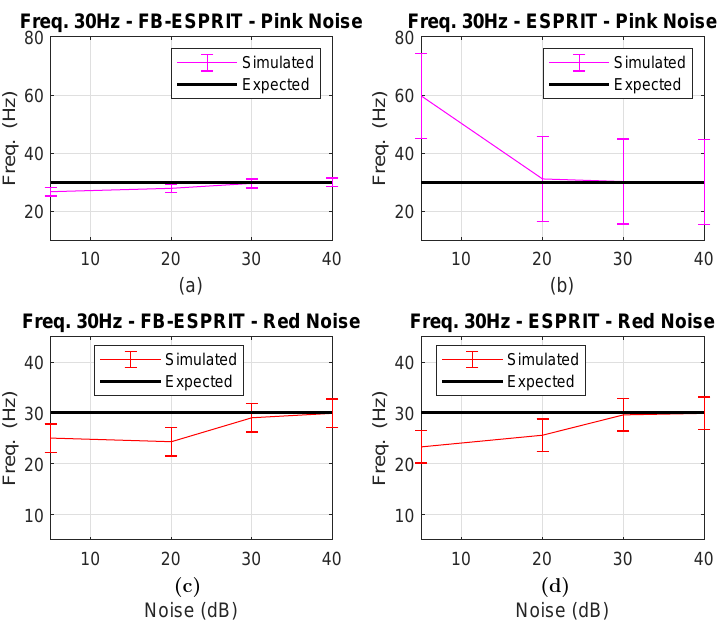
Figure 12. Estimation of the 30 Hz sub-harmonic frequency of the s 1 ( t ) signal contaminated with pink and red noises, indicating statistical deviations for SNR variation from 5 to 40 dB: ( a ) by FB-ESPRIT under pink noise, ( b ) by ESPRIT under pink noise, ( c ) by FB-ESPRIT under red noise, and ( d ) by ESPRIT under red